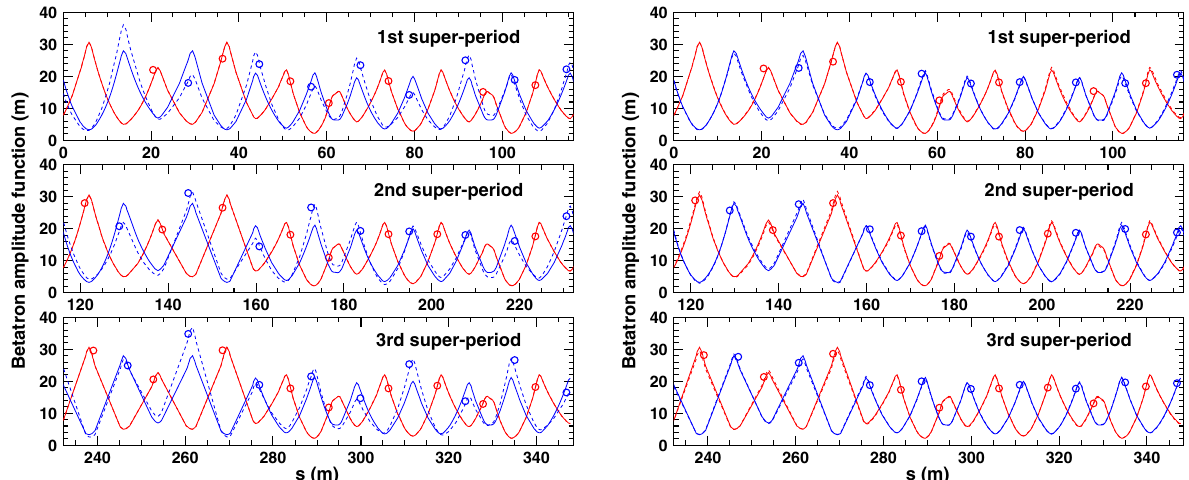
FIG. 30. Horizontal (red circles) and vertical (blue circles) betatron amplitude functions measured without (left) and with (right) QDTs when the injection bump is active, where the dashed curves are the corresponding calculated results, while the solid ones are the unmodulated betatron amplitude functions calculated with no injection